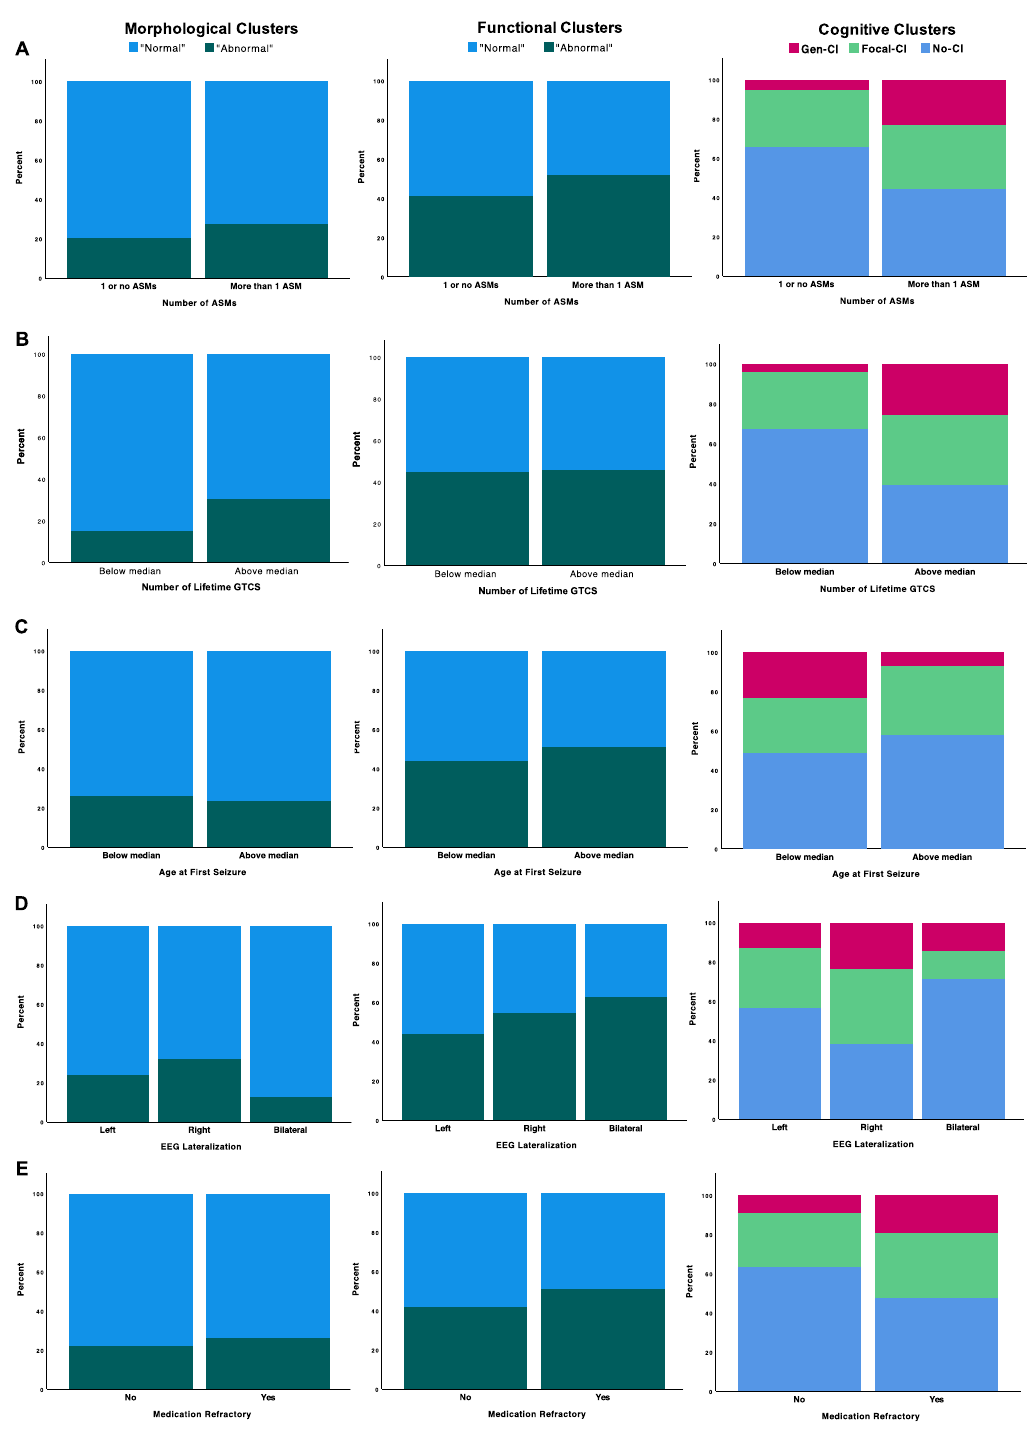
Figure 5. Proportion of TLE participants in (left) morphological clusters, (middle) functional clusters, and (right) cognitive clusters vs ( A ) number of ASMs (binarized), ( B ) lifetime number of GTCs (binarized), ( C ) age at first seizure (binarized), ( D ) EEG lateralization, and ( E ) medication